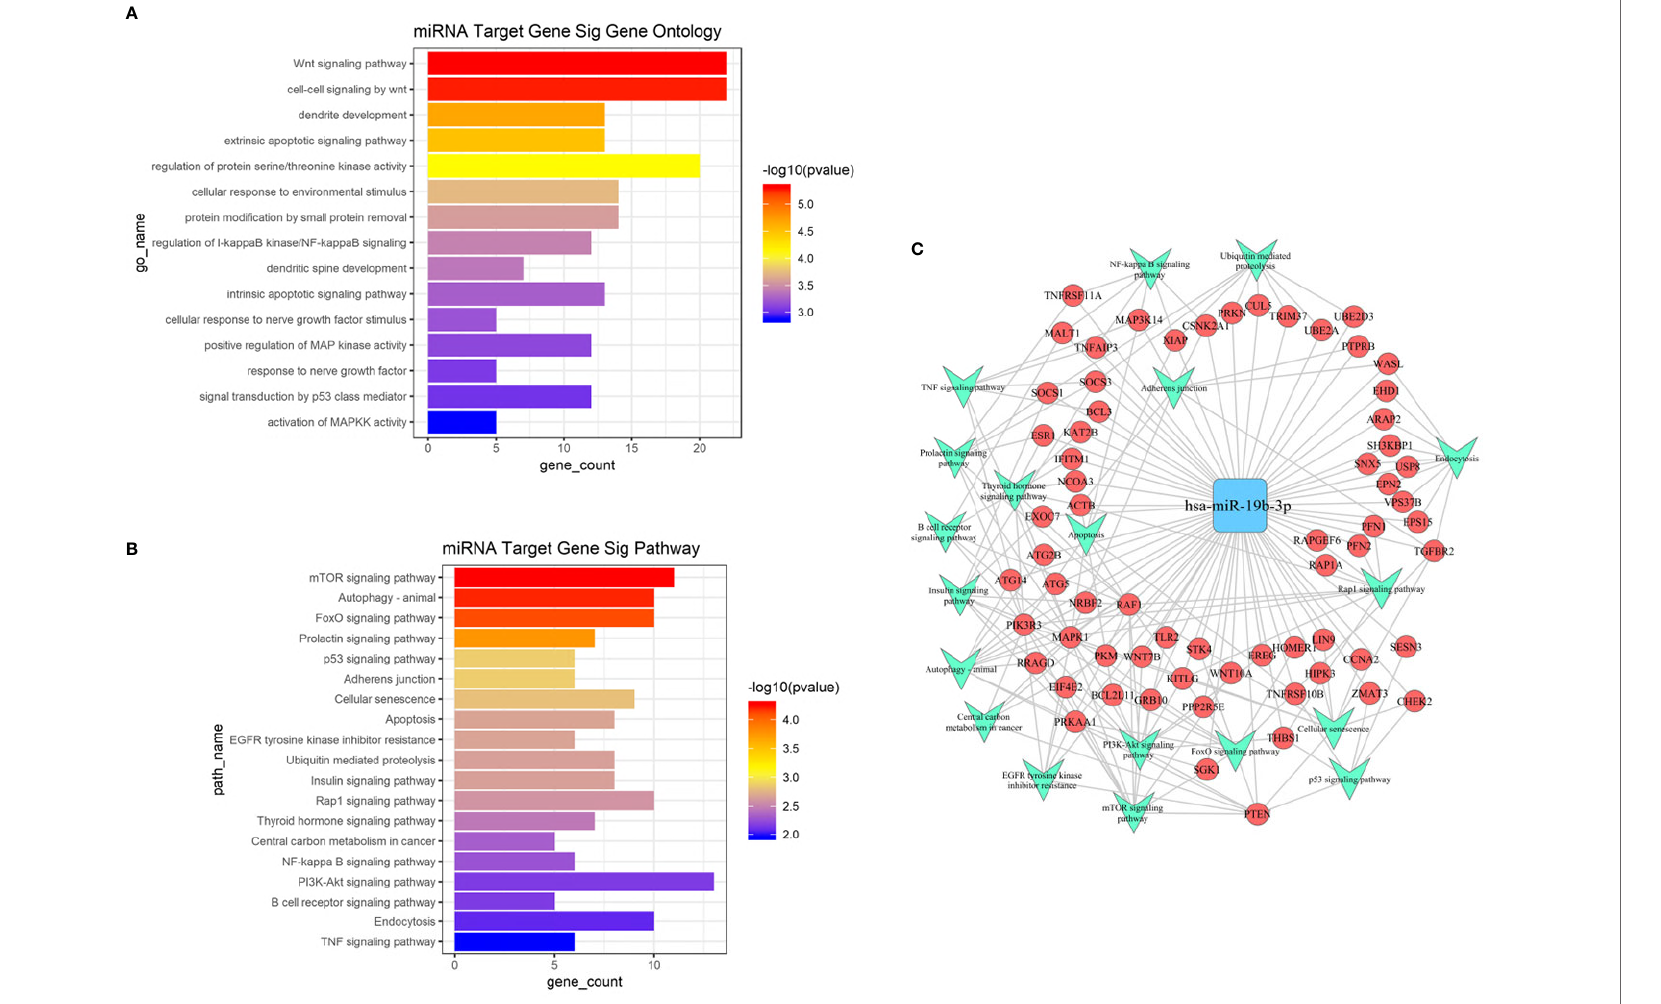
FIGURE 3 | (A) GO analysis of target genes predicted by miR-19b-3p. The ordinate is the name of the target gene function, and the abscissa is the negative logarithm of p value (-Lg p ). The larger the -Lg p value, the smaller the p value and the higher the signi fi cance level of the target gene function. (B) KEGG signal pathway of target genes predicted by miR-19b-3p. The ordinate is the name of the target gene signal pathway, and the abscissa is the negative logarithm of p value (-Lg p ). The larger the -Lg p value, the smaller the p value and the higher the signi fi cance level of the target gene signal pathway. (C) MicroRNA-Gene network diagram of miR-19b-3p. The blue square in the fi gure refers to miR-19b-3p, the red circle refers to target genes, and the green arrow refers to the signal pathways involved in the target gene. Lines represent the regulatory relationship between miR-19b-3p and target